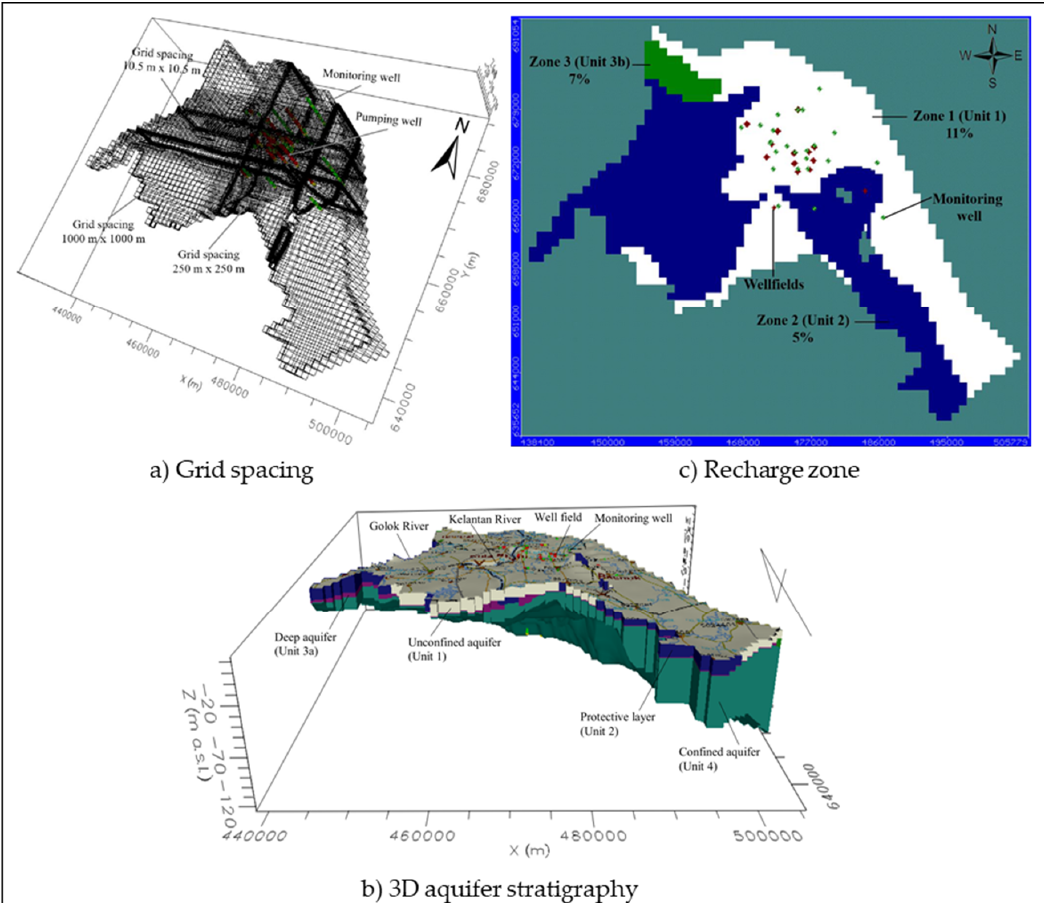
Figure 2. Model simulation ( a ) grid spacing; ( b ) 3D aquifer system; ( c ) and recharge zone.